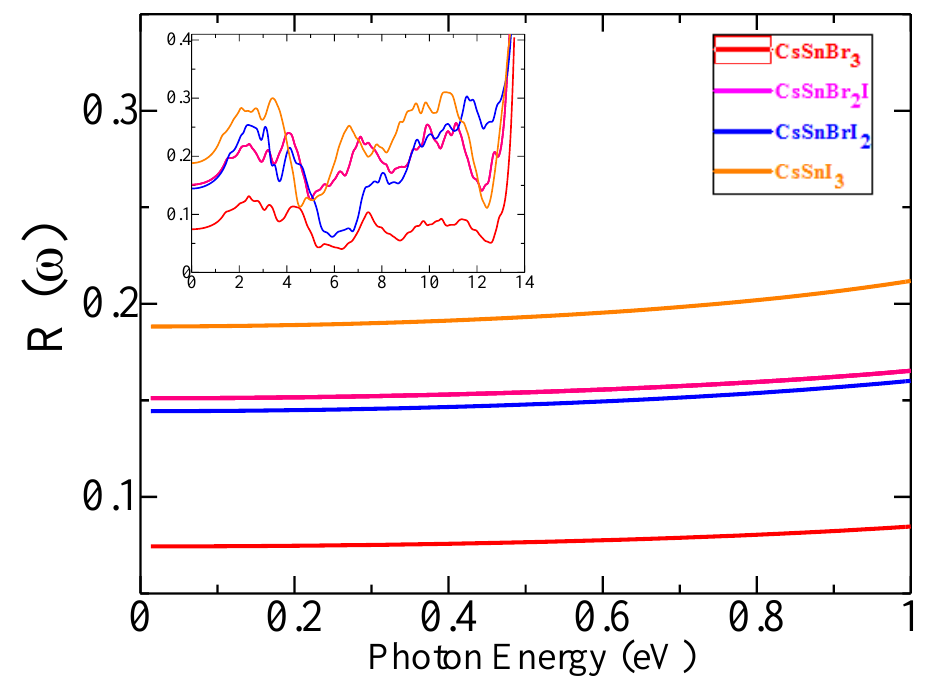
Figure 5. Reflectivity of perovskites of the CsSnBr3-xIx system depending on the energy (insert: R(ω) in the range 0 to 14